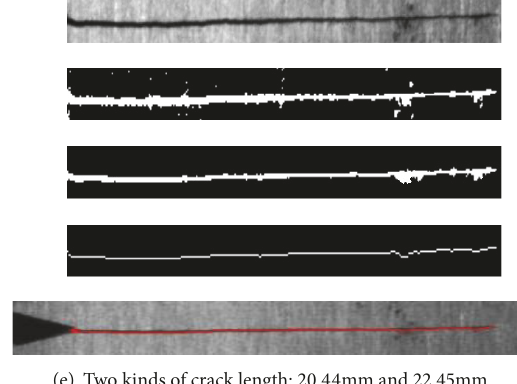
Figure 8: Result images in the process of crack extraction by the proposed method with different cracks